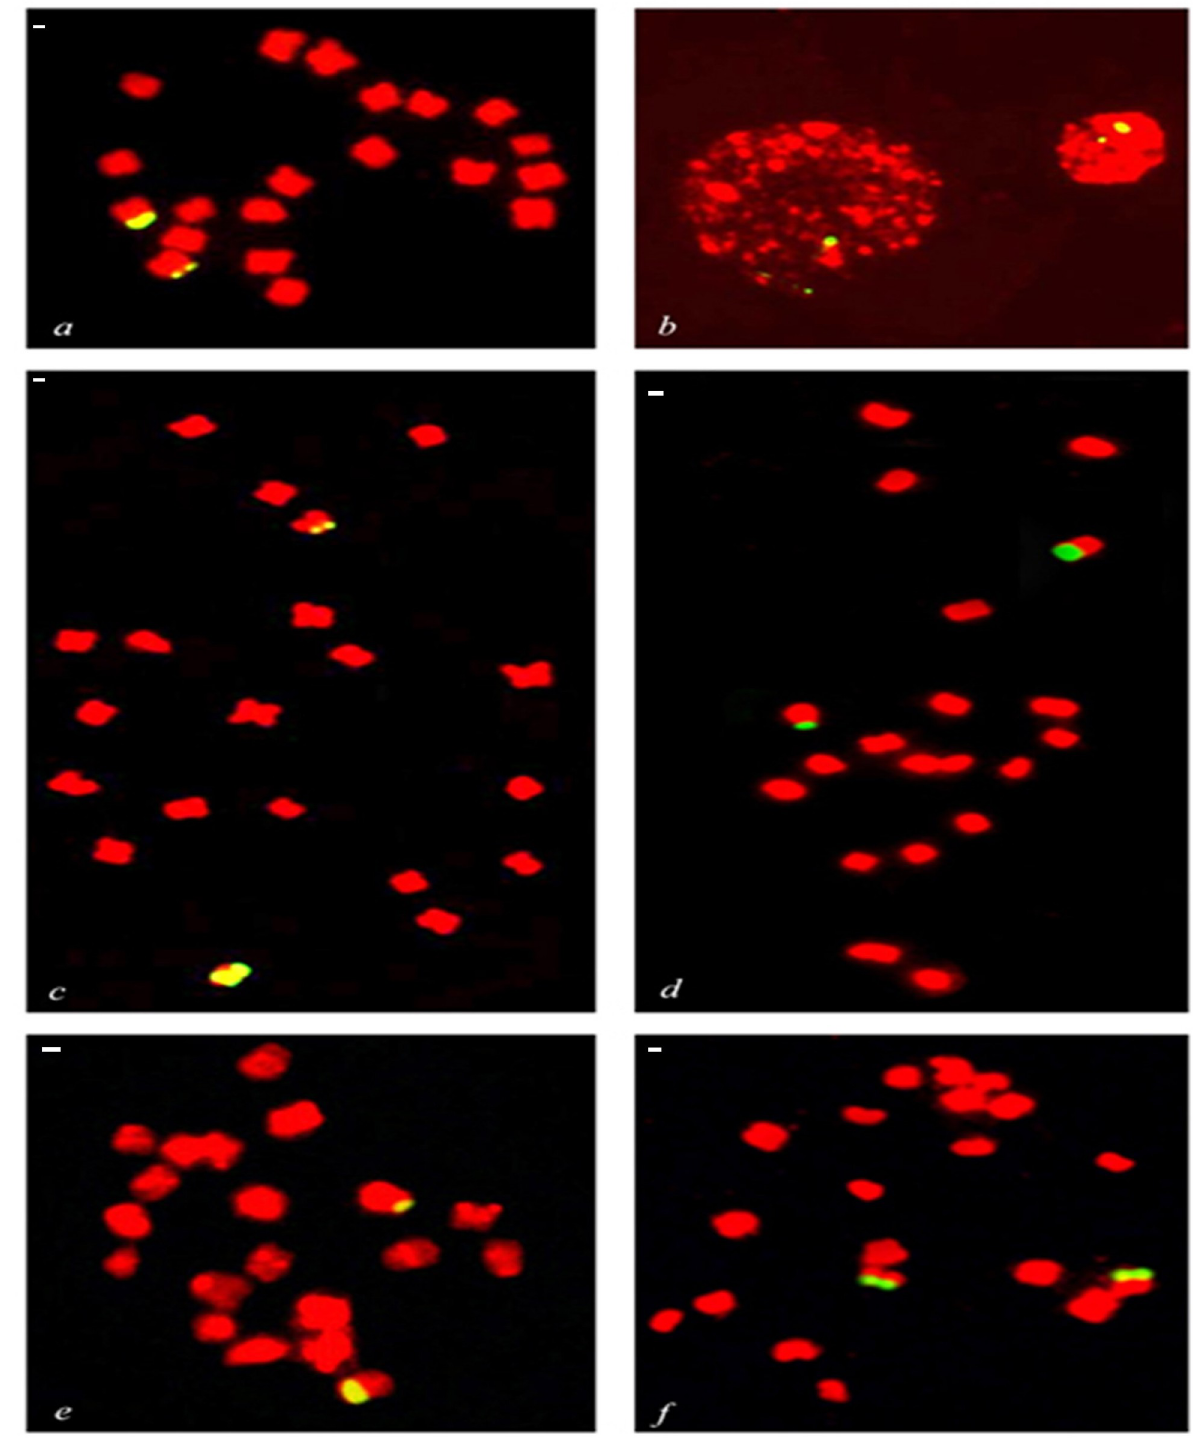
Fig 1. Mitotic cells of variety Bio-13, Medini, Manjiri ( C . winterianus ) and Krishna ( C . flexuosus ) after fluorescence in situ hybridization with 45S rDNA (yellow/green) as FISH probe. The chromosomes were counterstained with propidium iodide (red). (a and c) Somatic metaphase showing diploid chromosomes of Bio-13 (2 n = 20) showing differential hybridization signals of 45S rDNA on a pair of somatic chromosomes. (b) Interphase nuclei of Bio-13 showing differential hybridization signals of 45S rDNA (d) Somatic metaphase showing diploid chromosomes of Manjari (2 n = 20) showing differential hybridization signals of 45S rDNA on a pair of somatic chromosomes. (e) Somatic metaphase showing diploid